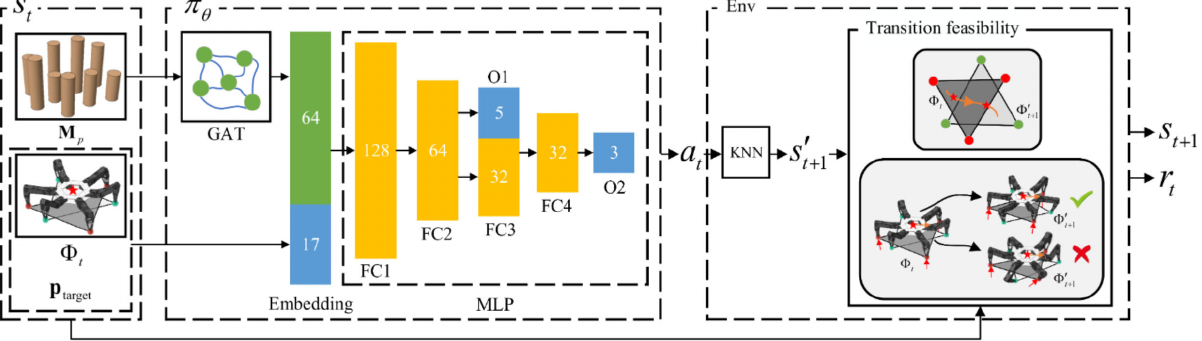
Figure 7. Overview of the DRL-based multi-contact motion planning method for hexapod robots.